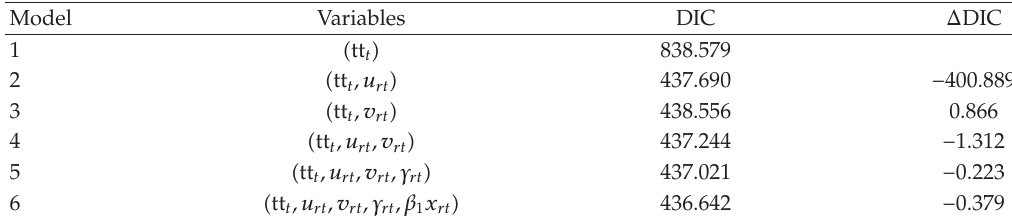
Table 3: Results of the model fit and selection criterion.